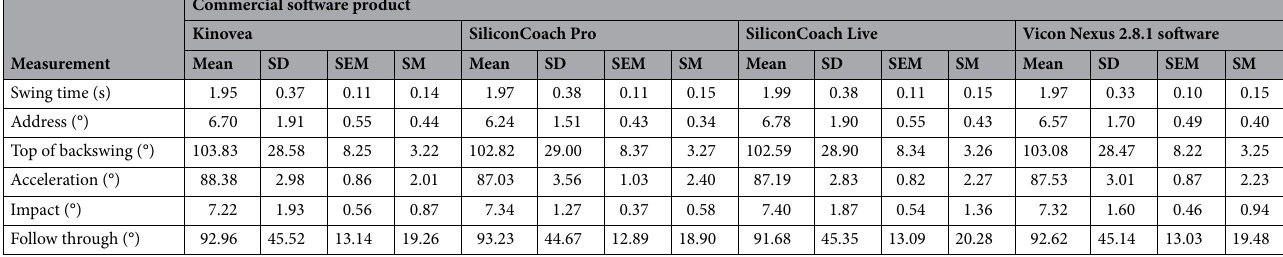
Table 1. Summary results for club angle with respect to vertical (°) and swing time